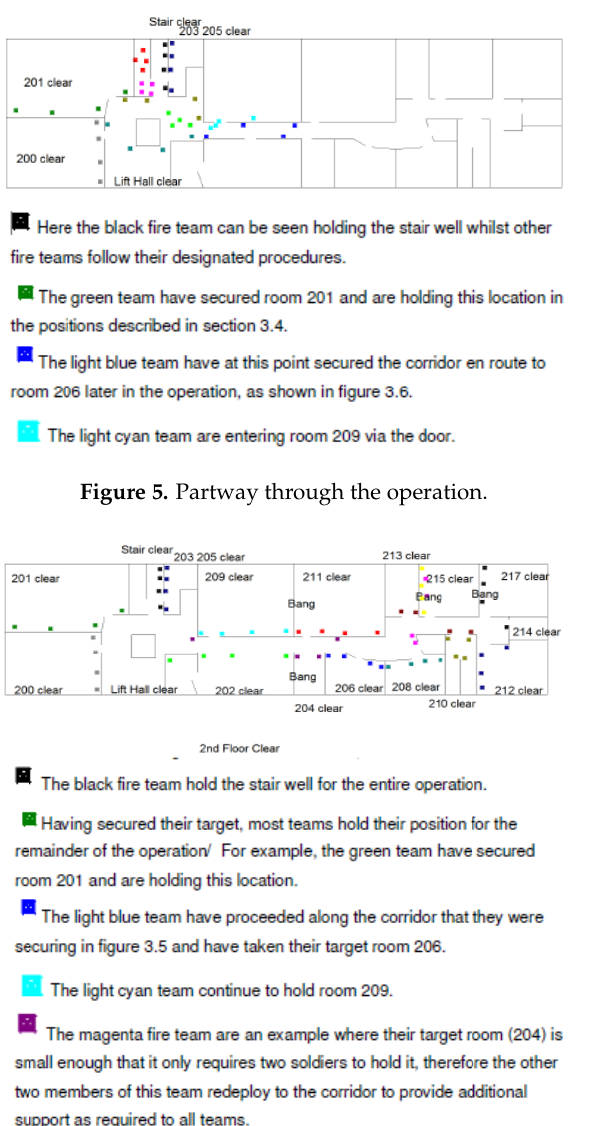
Figure 6. The end of the operation.